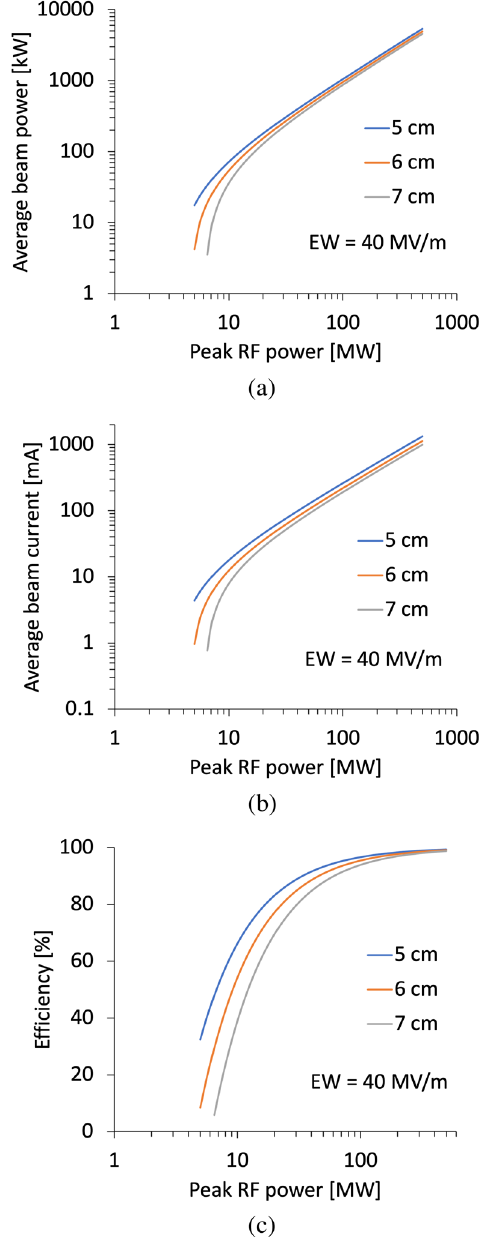
FIG. 10. (a) Average beam power, (b) average beam current, and (c) rf-to-beam efficiency; for eCRA ’ s at 2.856 GHz operating with peak wall fields of 40 MV = m, for three cavity radii. For these cavities, accelerations up to 4.03, 4.36, and 4.58 MeV, respectively, are